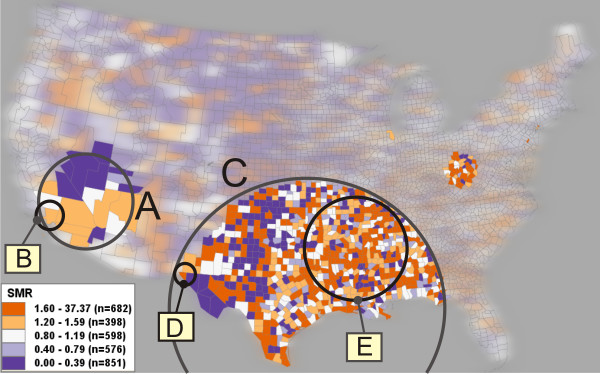
Heterogeneous versus core clusters. Clusters A and C are the heterogeneous clusters reported by SaTScan with a large maximum-size. Cluster B, D, E are identified as core clusters by the proposed reliability visualization. The clusters' properties are listed in Table 1. The clusters above are manually circled and labelled for illustration purposes. Other irrelevant clusters (e.g., a single-county cluster near the Great Lakes) are not circled and labelled.